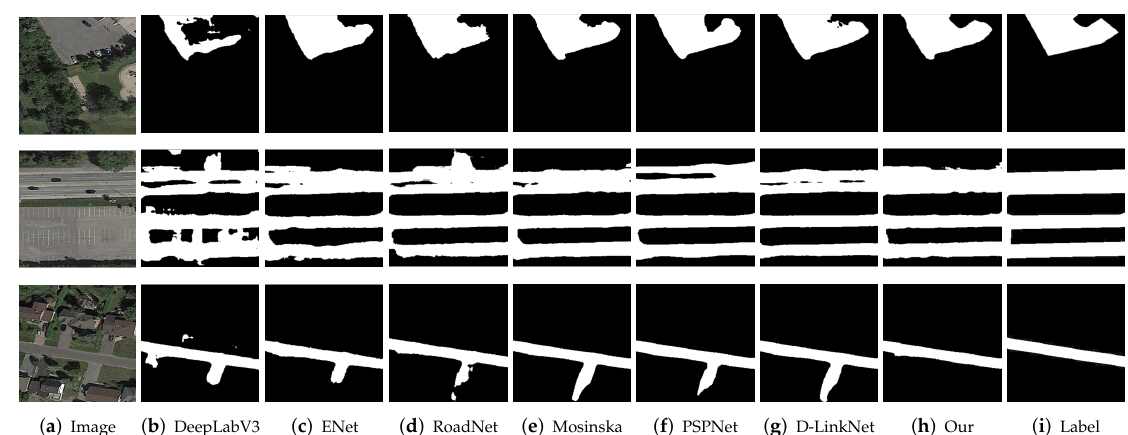
Figure 14. Performance comparison of student networks based on different methods with the RoadNet Dataset. ( a ) Image; ( b ) results of DeepLabV3 [35]; ( c ) results of ENet [33]; ( d ) results of RoadNet [18]; ( e ) results of Mosinska [20]; ( f ) results of PSPNet; [34]; ( g ) results of D-LinkNet [11]; ( h ) results of our method (TSKD-Road); ( i ) label.